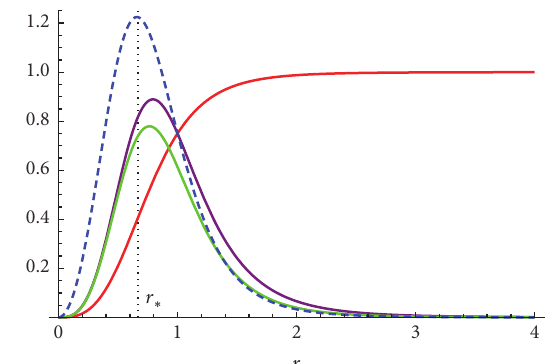
𝑓(𝑟) (red), 𝑓 󸀠 (𝑟)𝑟 (purple), and 𝑓 󸀠 (𝑟)𝑟(1 − 2𝑟 2 /(𝑏 2 + 3𝑟 2 )) (green). The curve of 𝑓 󸀠 (𝑟) , the dashed blue curve with 𝑓 󸀠󸀠 (𝑟 ∗ ) = 0 , is drawn for